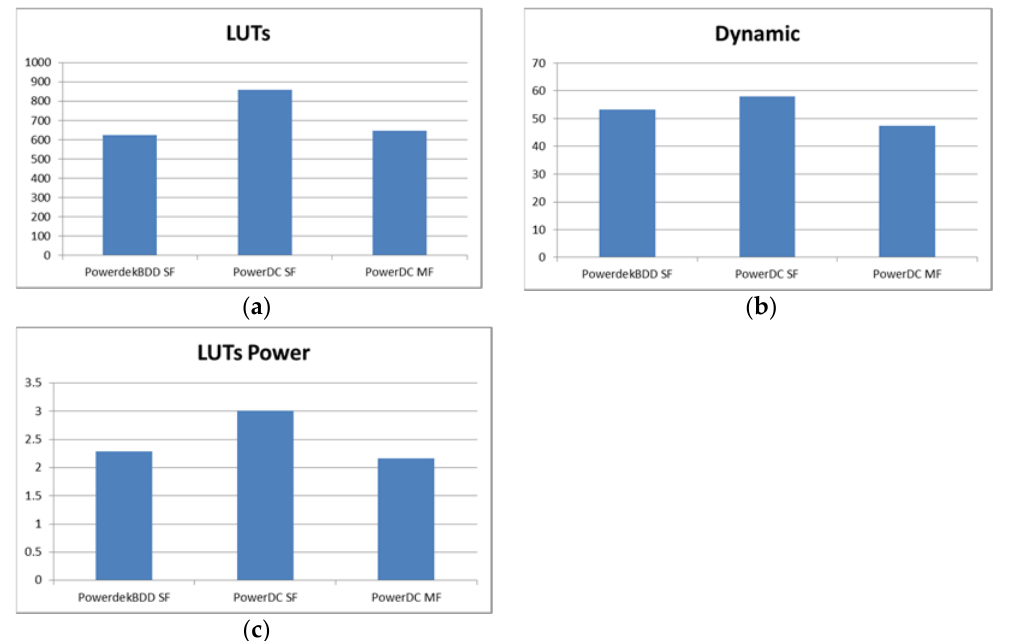
Figure 7. Comparison of the results obtained via Vivado in terms of: ( a ) number of LUT blocks; ( b ) dynamic power consumption; ( c ) power consumption by LUTs.